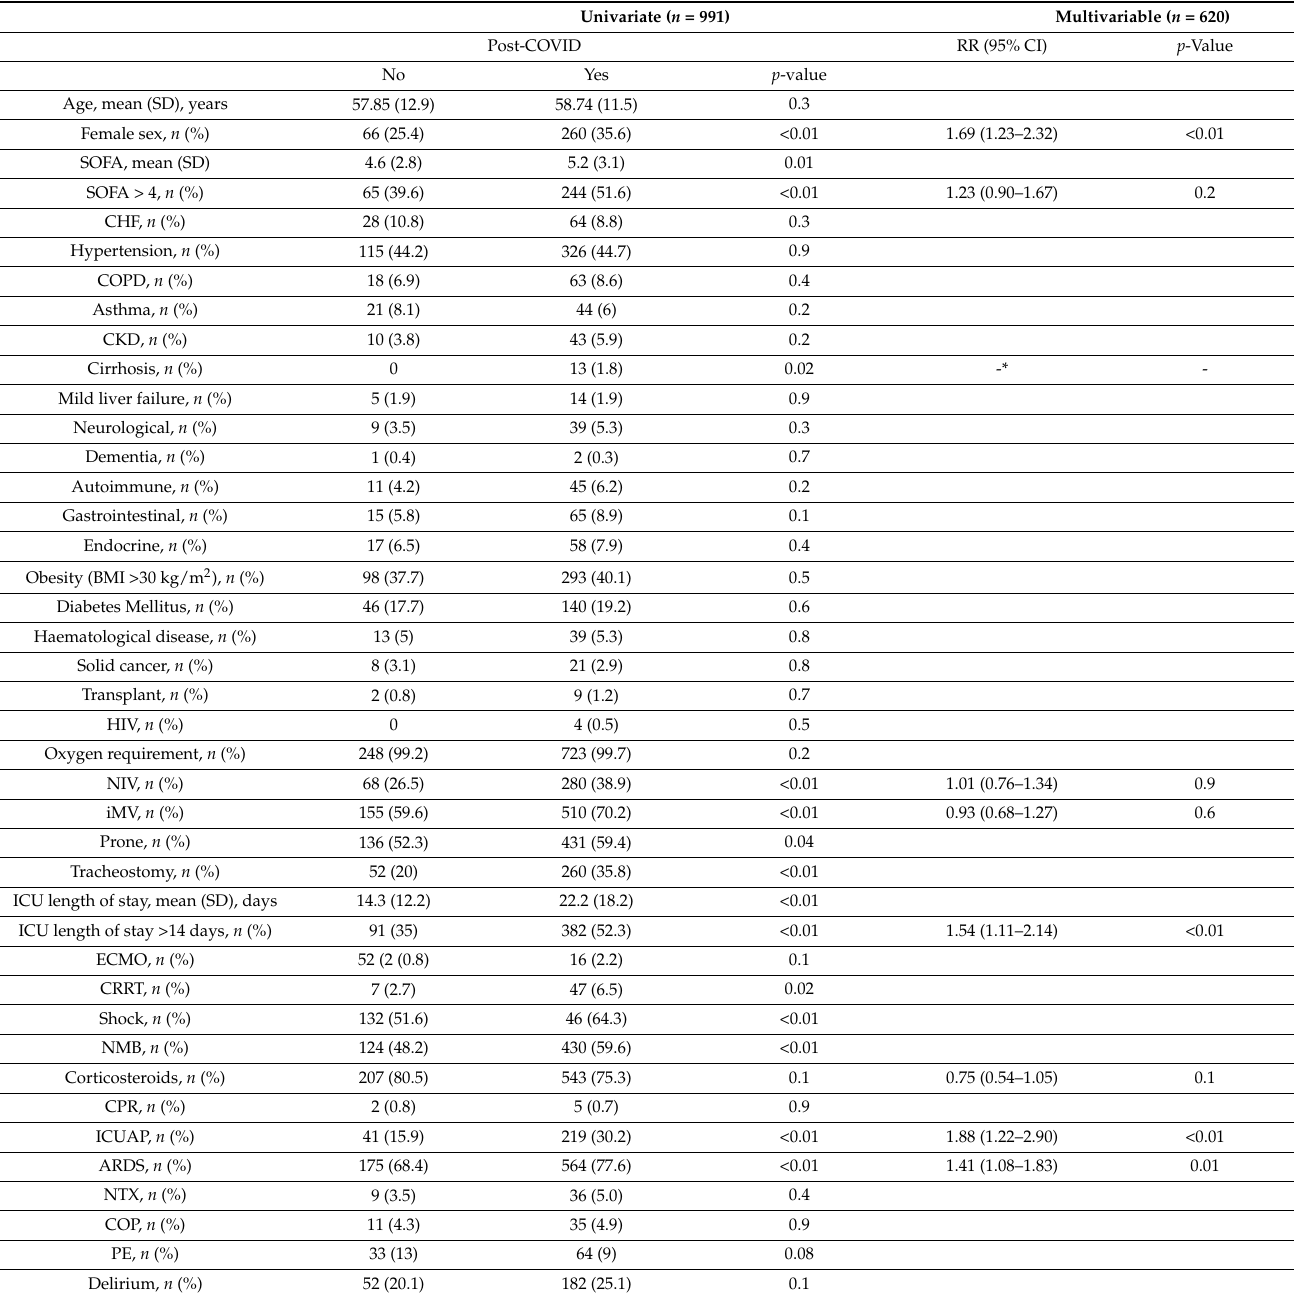
Table 5. Univariate and multivariate analyses of factor associated with persistent post-COVID-19 symptoms at 3-month follow-up. Univariate ( n = 991) Multivariable ( n =